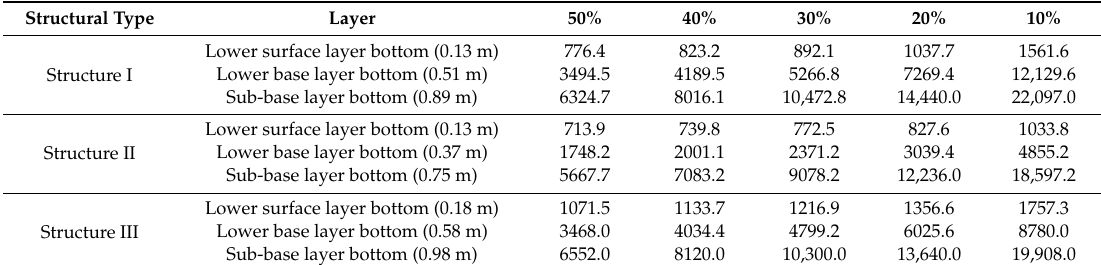
Table 7. Envelope area of stress transfer path (unit: cm 2